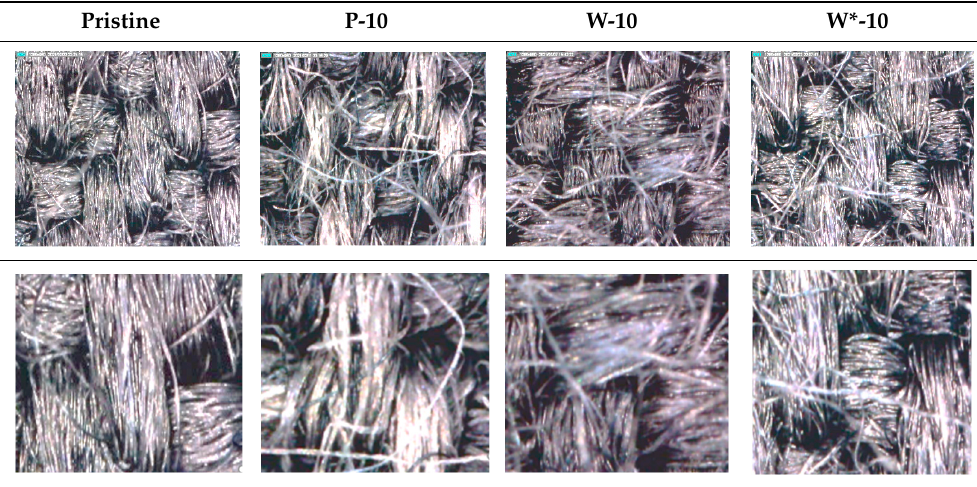
(W*-10). Table 7. Digital micrographs of PES/CO/SS fabric before and after 10 cycles of dry cleaning (P-10), Table 7 . Digital micrographs of PES/CO/SS fabric before and after 10 cycles of dry cleaning (P-10), 267 Table 7 . Digital micrographs of PES/CO/SS fabric before and after 10 cycles of dry cleaning (P-10), Table 7 . Digital micrographs of PES/CO/SS fabric before and after 10 cycles of dry cleaning (P-10), 267 Table 7 . Digital micrographs of PES/CO/SS fabric before and after 10 cycles of dry cleaning (P-10), 267 wet cleaning (W-10 and W*-10) with macro-sized fragments. Table 7 . Digital micrographs of PES/CO/SS fabric before and after 10 cycles of dry cleaning (P-10), 267 Table 7 . Digital micrographs of PES/CO/SS fabric before and after 10 cycles of dry cleaning (P-10), 267 Table 7 . Digital micrographs of PES/CO/SS fabric before and after 10 cycles of dry cleaning (P-10), 267 Table 7 . Digital micrographs of PES/CO/SS fabric before and after 10 cycles of dry cleaning (P-10), 267 wet cleaning (W-10 and W*-10) with macro-sized fragments . wet cleaning (W-10 and W*-10) with macro-sized fragments . wet cleaning (W-10 and W*-10) with macro-sized fragments . wet cleaning (W-10 and W*-10) with macro-sized fragments . wet cleaning (W-10 and W*-10) with macro-sized fragments wet cleaning (W-10 and W*-10) with macro-sized fragments . 268 wet cleaning (W-10 and W*-10) with macro-sized fragments . 268 wet cleaning (W-10 and W*-10) with macro-sized fragments . 268 Pristine P-10